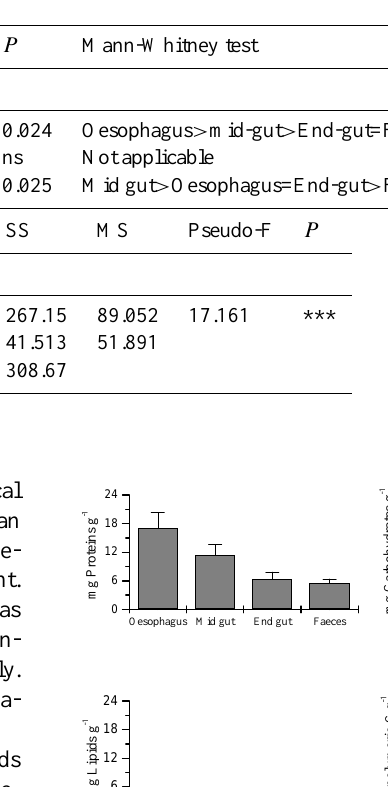
Table 3. Results of the Kruskal-Wallis ANOVA (a) and PERMANOVA (b) tests carried out to ascertain differences in the quantity (ANOVA) and biochemical composition (PERMANOVA) of sediment OM among the various sections of the holothurians’ gut and the faeces. DF = degrees of freedom, H = Kruskal-Wallis H, P = P-level, SS = sum of squares; MS = mean square; F = F statistic; P = probability level; *** = P < 0 . 001 Oesophagus: first part of the gut; mid gut: second part of the gut; others: nd gut and faeces (see material and methods for details). P-level for non parametric ANOVA were Bonferroni corrected.